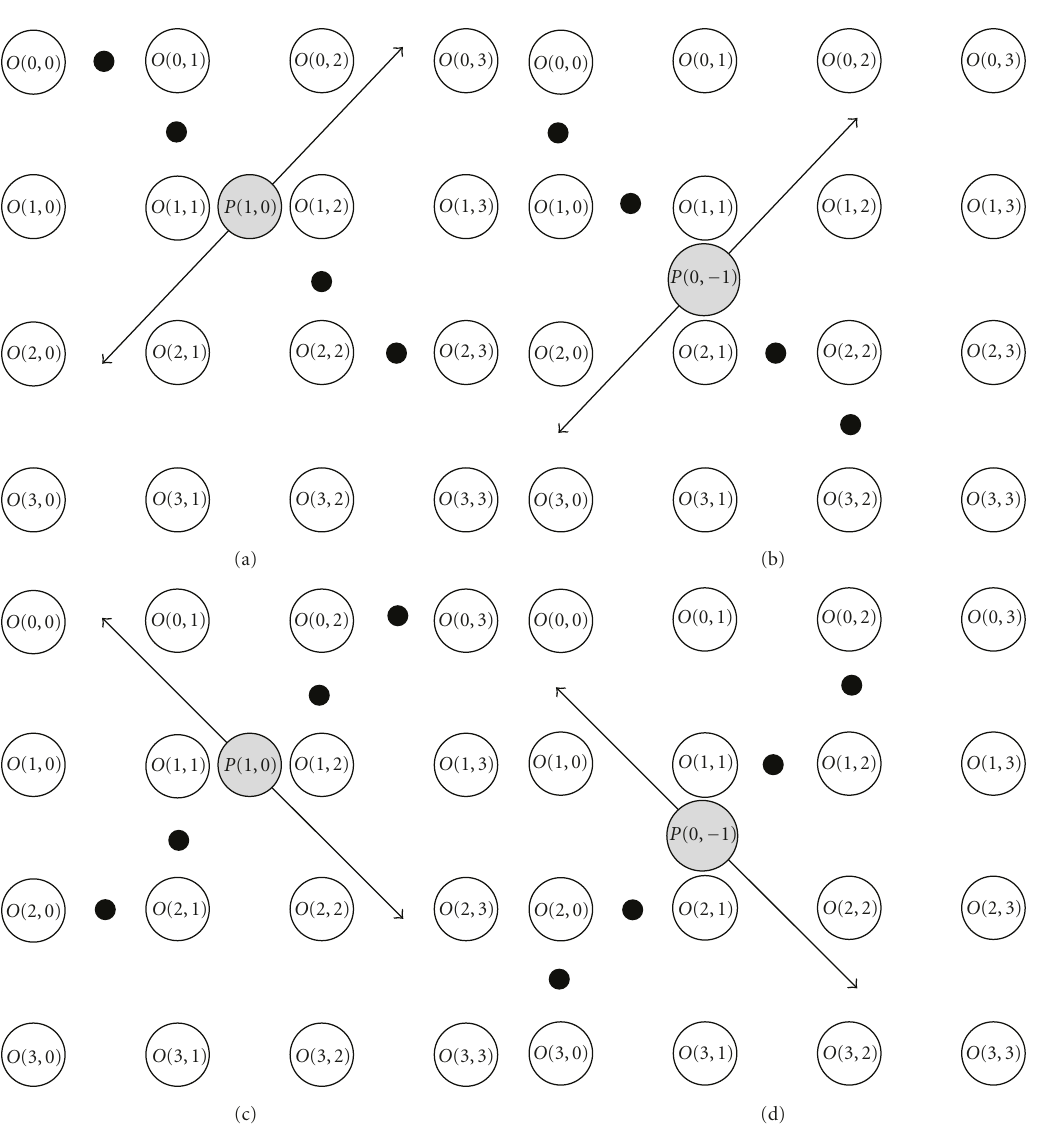
Figure 8: Interpolation for (a) P (1,0) and (b) P (0, − 1) in a 45-degree edge block and interpolation for (c) P (1,0) and (d) P (0, − 1) in a 135-degree edge